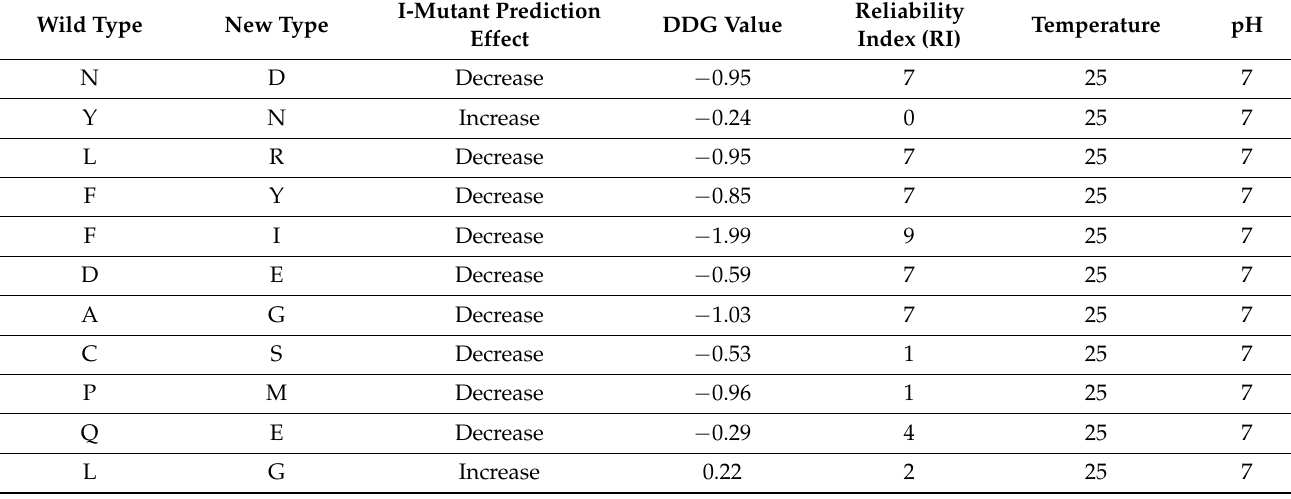
Table 10. MexB gene Prediction results of I-Mutant